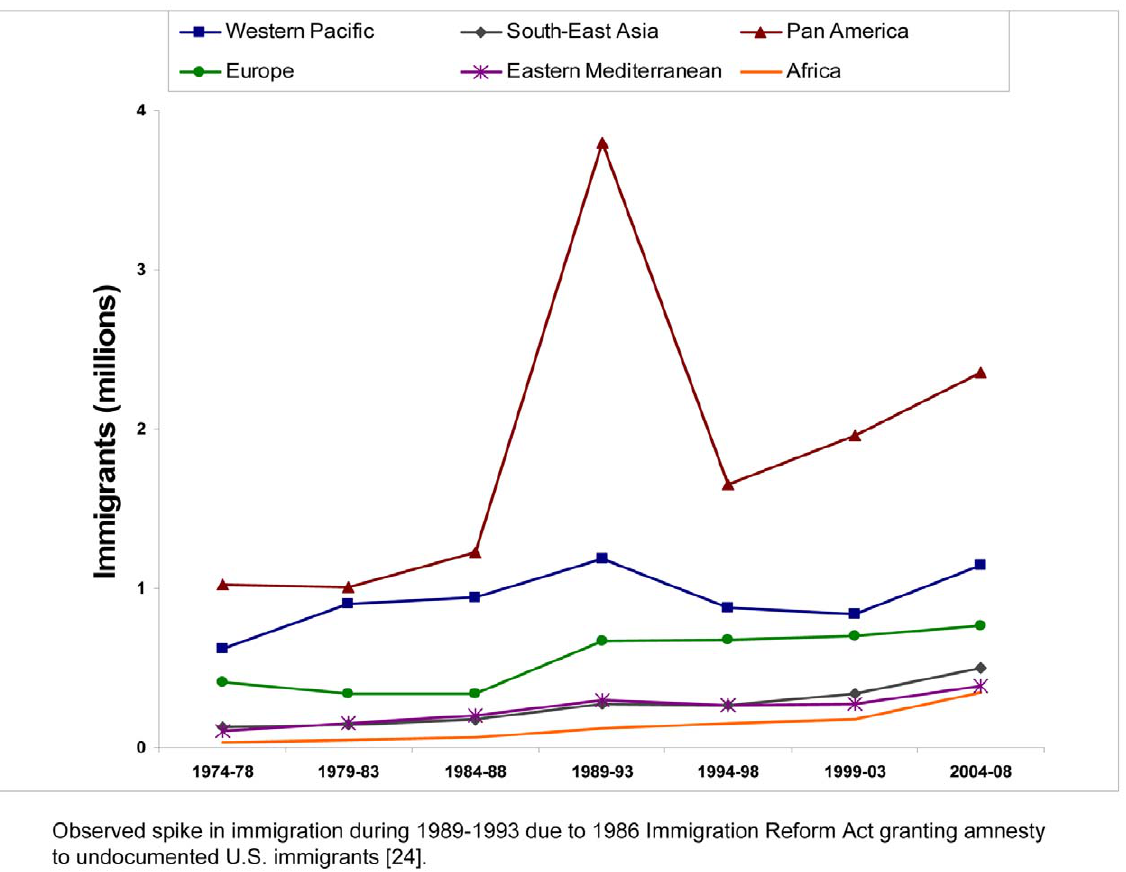
Figure 1. U.S. Immigration by WHO Region of Origin, 1974–2008.